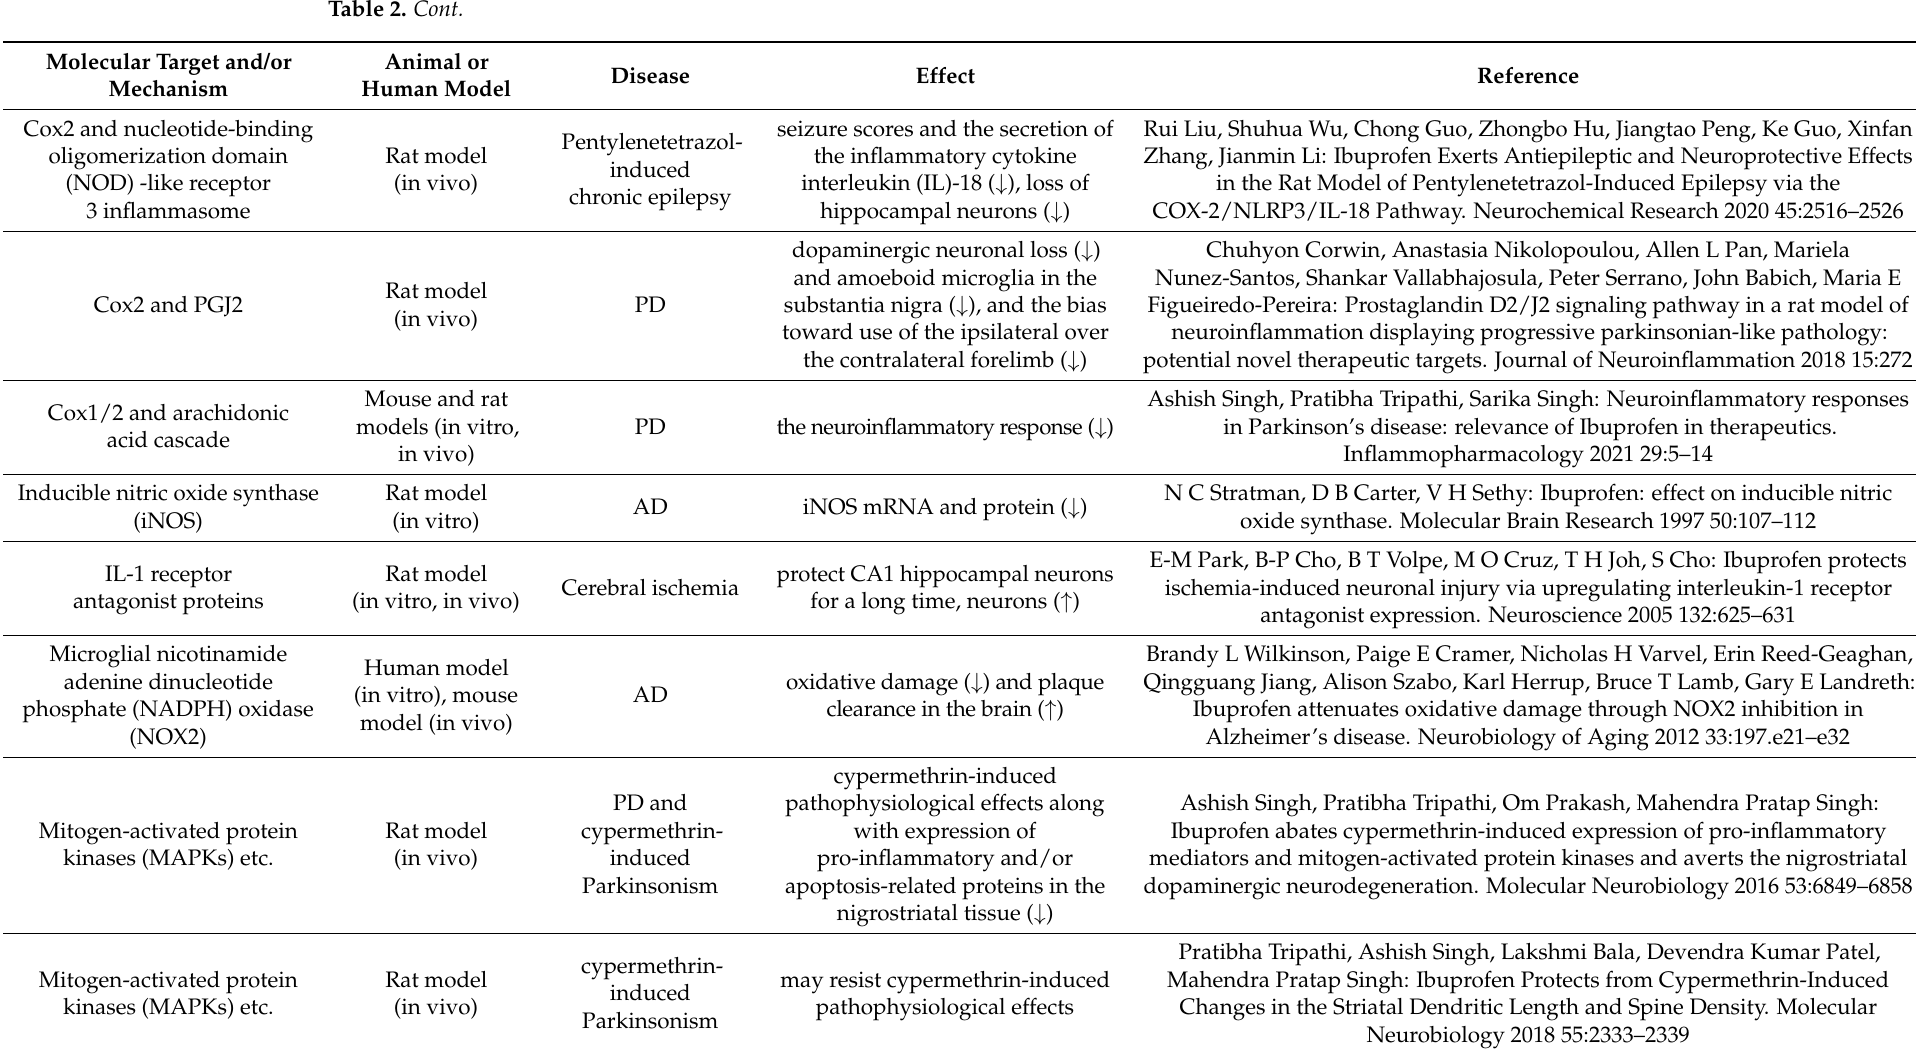
Figueiredo-Pereira: Prostaglandin D2/J2 signaling pathway in a rat model of neuroinflammation displaying progressive parkinsonian-like